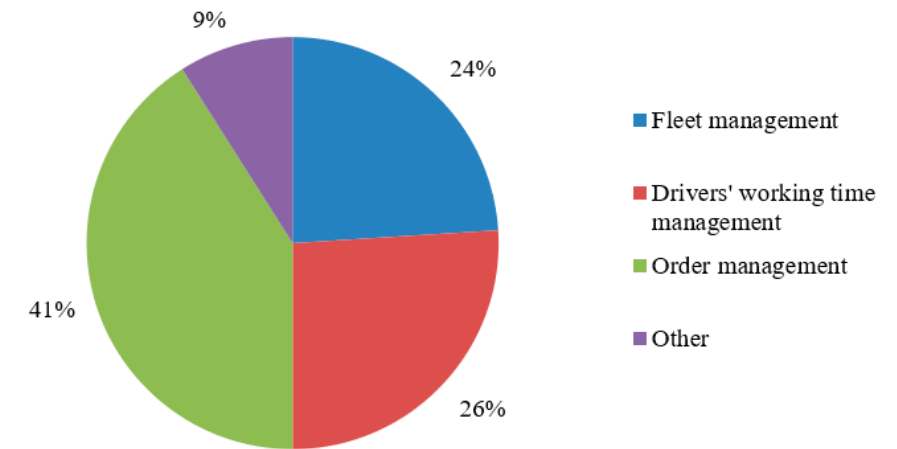
Table 1. Enterprises (employing more than 9 drivers) operating in the sector of commercial road transport, as organised by the number of owned trucks / lorries and road tractor units. Enterprises with the Number of Lorries and Road Tractors Total 6 or Less 6–9 10–19 20–49 50–99 100 or More 2014 3969 276 673 1839 910 188 83